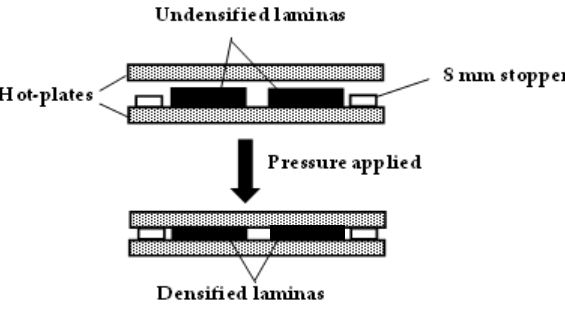
Figure 1. Diagram of the densification setup.